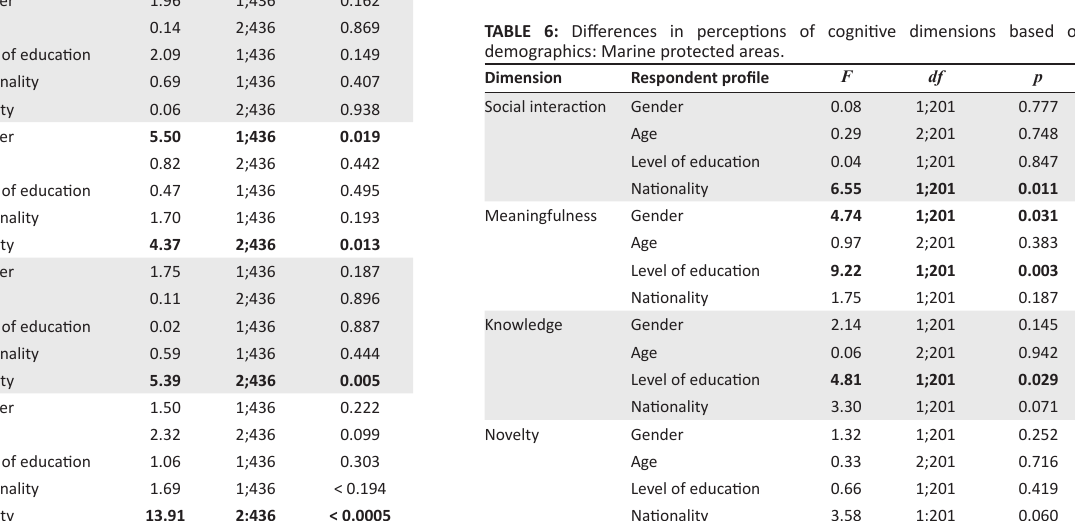
TABLE 4: Differences in perceptions of cognitive dimensions based on demographics. Dimension